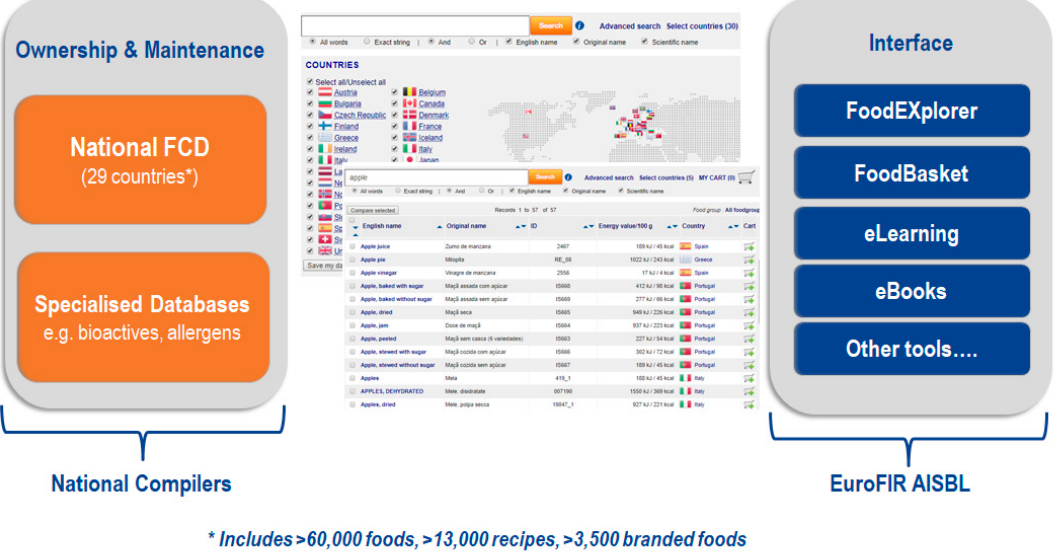
Figure 2. EuroFIR Food Information Platform.